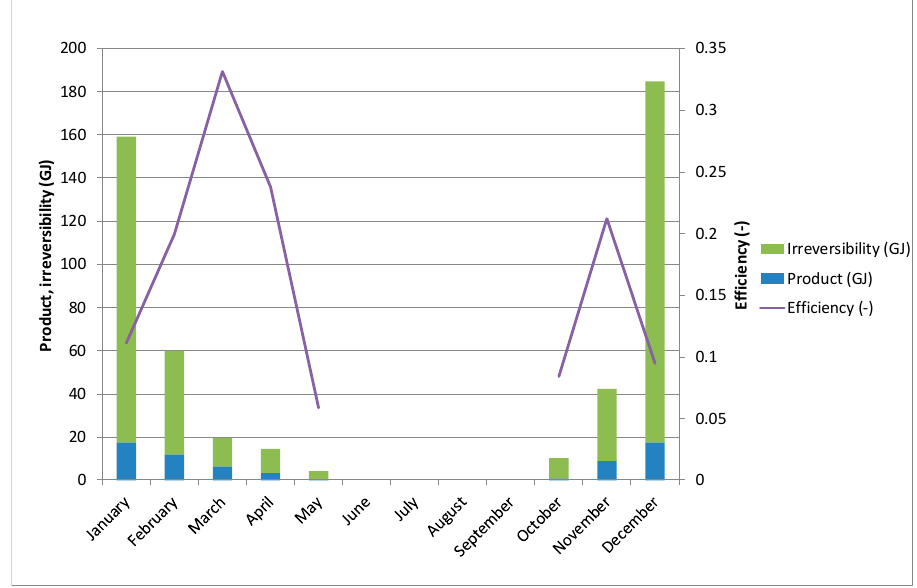
Figure 14. Gas boiler: Product, irreversibility, and efficiency.